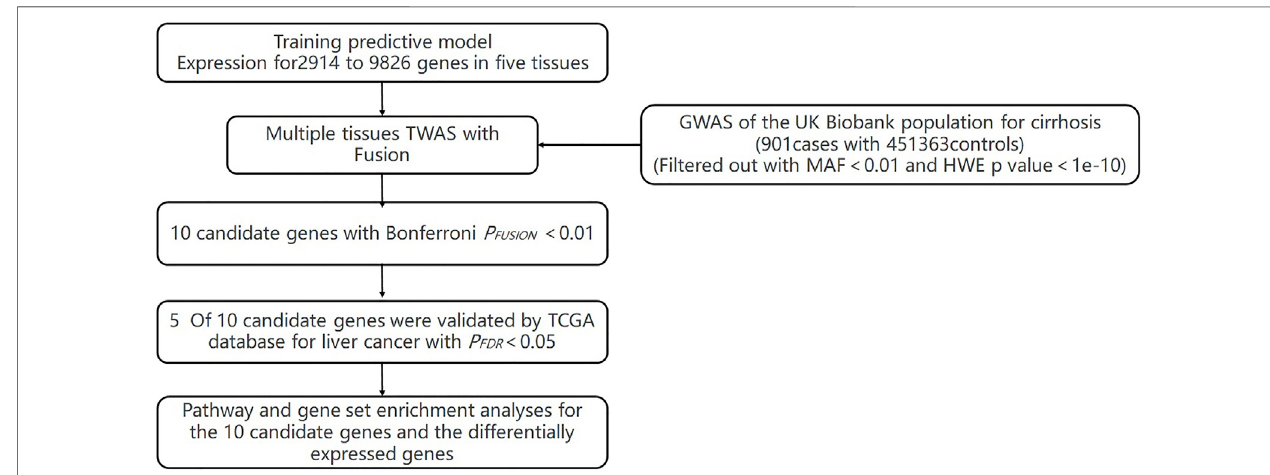
FIGURE 1 | Flowchart of the